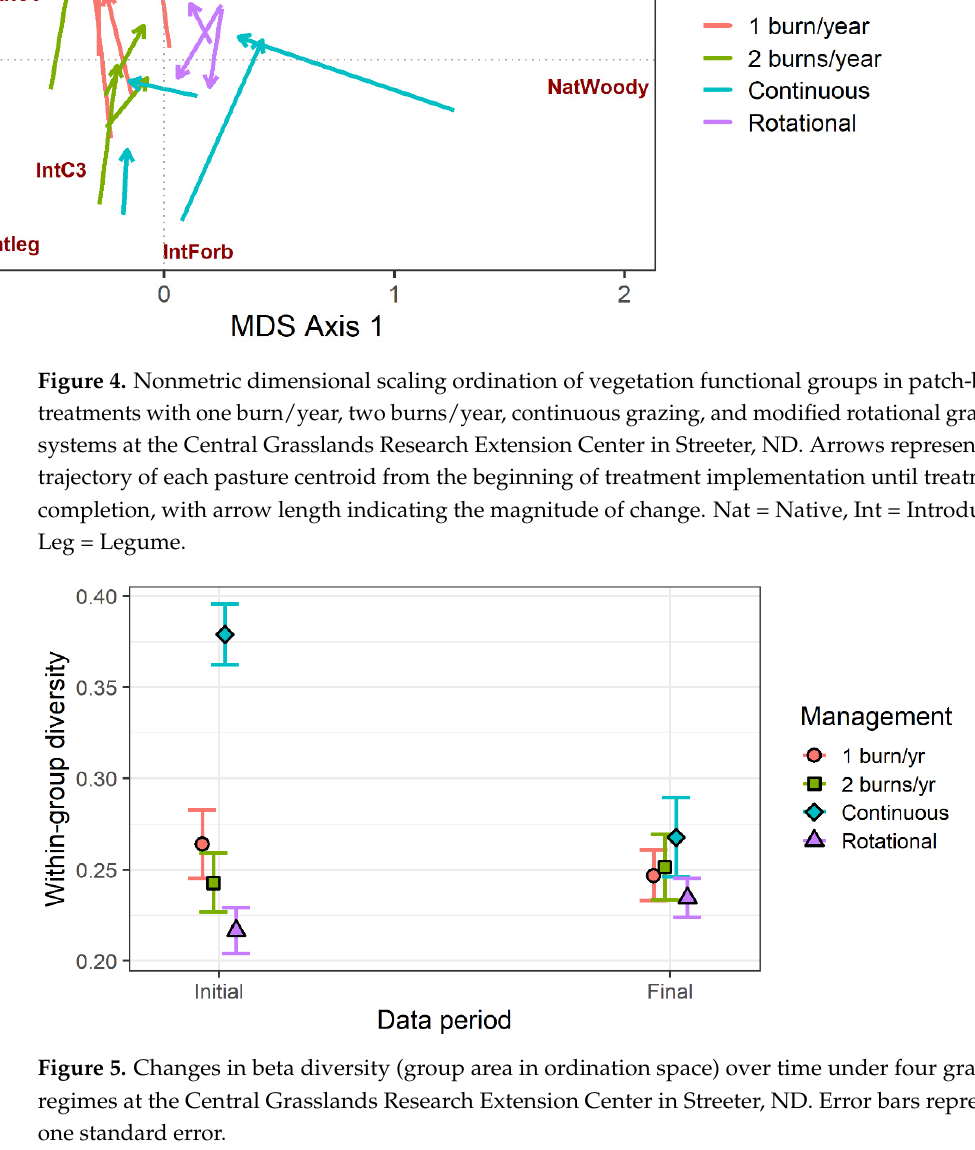
Figure 6. Changes in vegetation structure over time under four grazing regimes at the Central Grass- lands Research Extension Center in Streeter, ND. Error bars represent one standard error. Spatial heterogeneity was greatest in the PBG1 treatment compared to the other three treatments, and remained high throughout the study period (Figure 7). Litter cover spatial heterogeneity was again highest in PBG1 pastures at the beginning of the study period, but values were similar between PBG1 and continuous pastures by the end of the study (Figure 7). Heterogeneity in Robel height and litter depth tended to be low in PBG2 and continuous pastures (Figure 7). Modified rotational pastures had low spatial heterogene- ity at the beginning of the study period, but heterogeneity increased over time, rivaling heterogeneity levels in PBG1 pastures by the completion of the study (Figure 7). Changes in spatial heterogeneity over time were not different relative to continuous grazing for